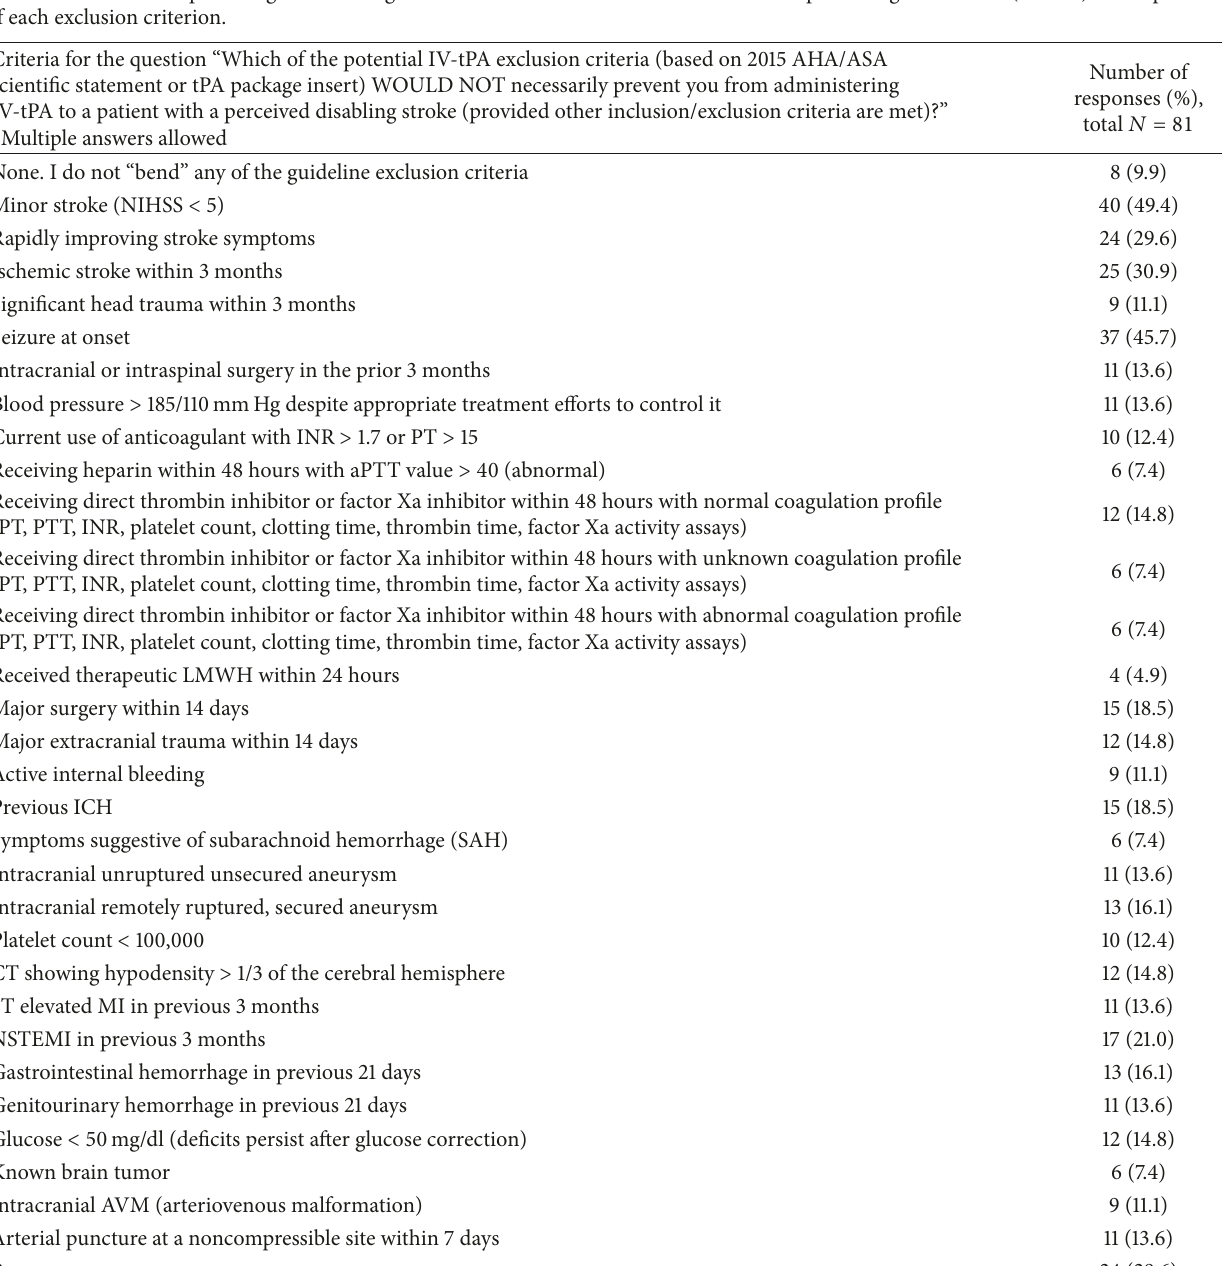
Table 2: Number and percentage of neurologists who would administer intravenous tissue plasminogen activator (IV-tPA) in the presence of each exclusion